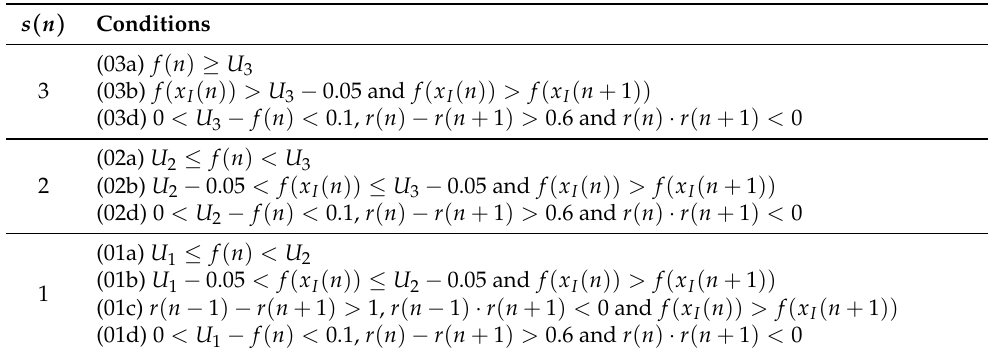
Table 6. Conditions for status change with s ( n − 1 ) = 0.